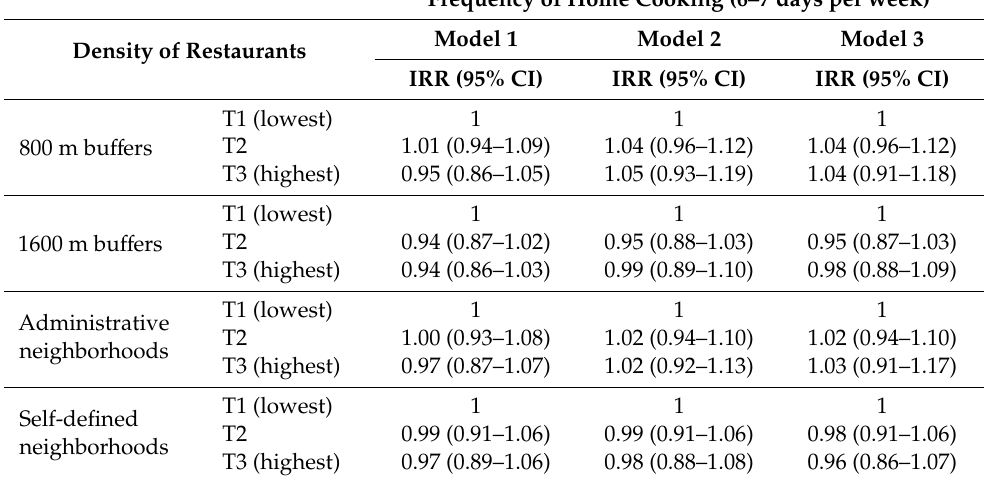
Table 5. Incidence rate ratio (IRR) and 95% confidence intervals (95% CI) as derived from Poisson regression analyses indicating the associations between density of restaurants, according to four di ff erent definitions of neighborhoods, with weekly frequency of cooking at home among adults in the Netherlands. The SPOTLIGHT Project ( n =